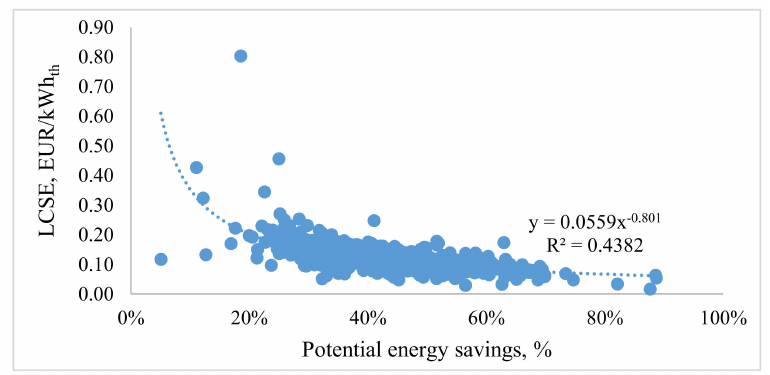
Figure 7. The correlation analyses for levelized costs of saved energy (LCSE) and achieved energy saving